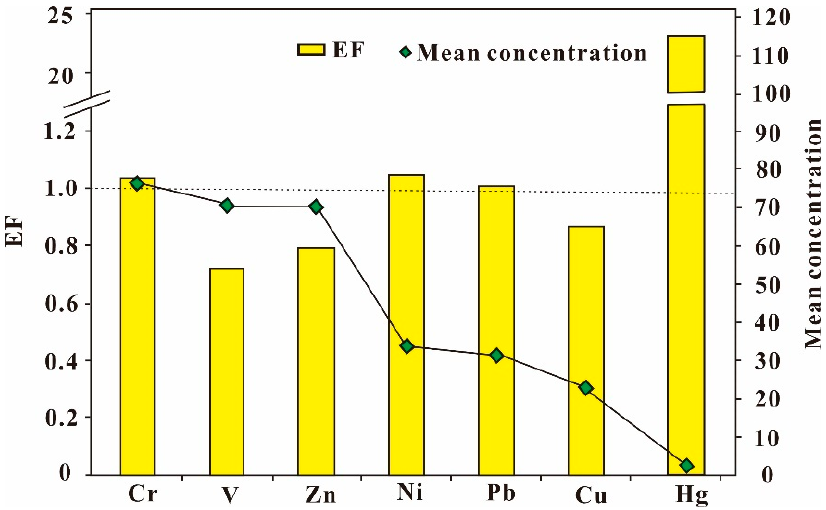
Figure 4. The relationship between EF and the mean concentration of each